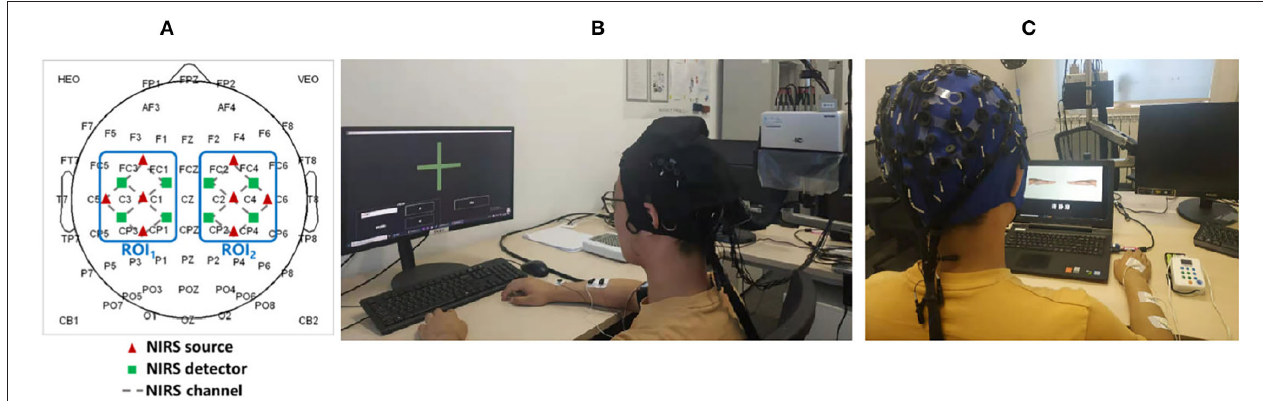
FIGURE 4 | (A) Signal acquisition sensor configuration (B) Standard assessment session (C) Multimodal NFT session.